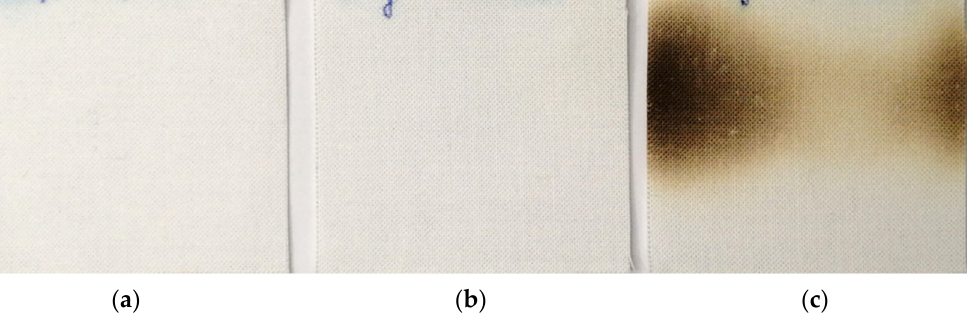
Figure 7. Damage to the cotton swatches after the microwave treatment; ( a ) 700 W, 10 s; ( b ) 700 W, 20 s; ( c ) 700 W, 30 s.